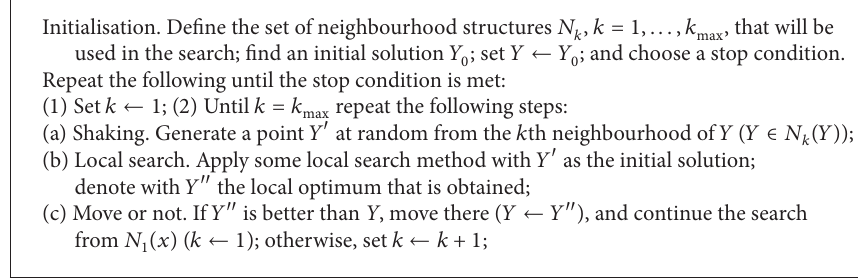
Algorithm 1: The basic VNS scheme.